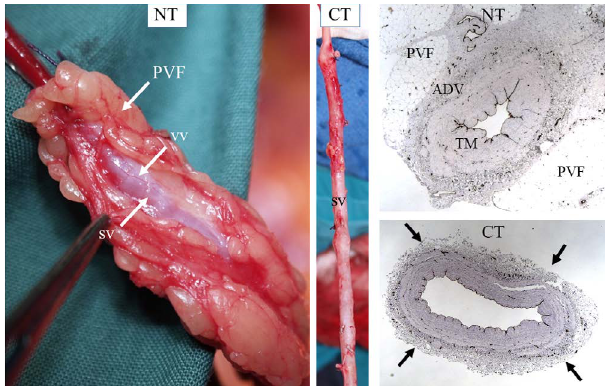
Fig. 2 - Vascular damage; no-touch (NT) versus conventional (CT) saphenous vein (SV). Left panel shows explants of NT and CT SV used for coronary artery bypass grafting. The perivascular fat (PVF) surrounding the SV remains intact, and the superficial adventitial vasa vasorum (VV) is visible in the NT SV. The CT SV has PVF removed, and adventitia (ADV) is stripped off or partially damaged. Right panel shows transverse sections of NT (top) and CT (lower) SV stained with haematoxylin and eosin and endothelial cells identified using CD31. The PVF and ADV remain intact on NT SV, but PVF is removed on CT SV. The vessels wall is thicker in NT than CT SV. A high proportion of the ADV and associated VV (dark punctate staining) is damaged/ removed in CT SV (arrows). TM=tunica